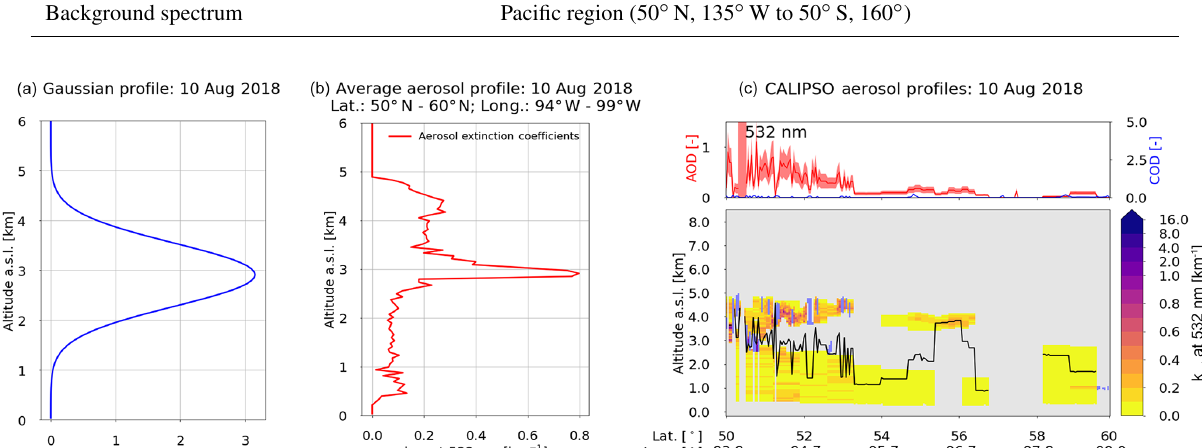
Figure 1. (a) CHOCHO and HCHO profiles assumed in the computation of AMFs (air mass factors). (b) CALIPSO profile of aerosol extinction coefficients ( k ext ), averaged over for all latitudes and longitudes of panel (c) , excluding cloudy scenes. (c) Top panel: example of CALIPSO aerosol profile extinction coefficients retrieved at a wavelength of 532nm. Aerosol and cloud optical depths (AOD and COD, respectively) are shown as a function of latitude and longitude for every single profile. Bottom panel: colour-coded k ext for every latitude and longitude in the selected region. Purple spots represent cloudy scenes. The black line depicts the aerosol layer